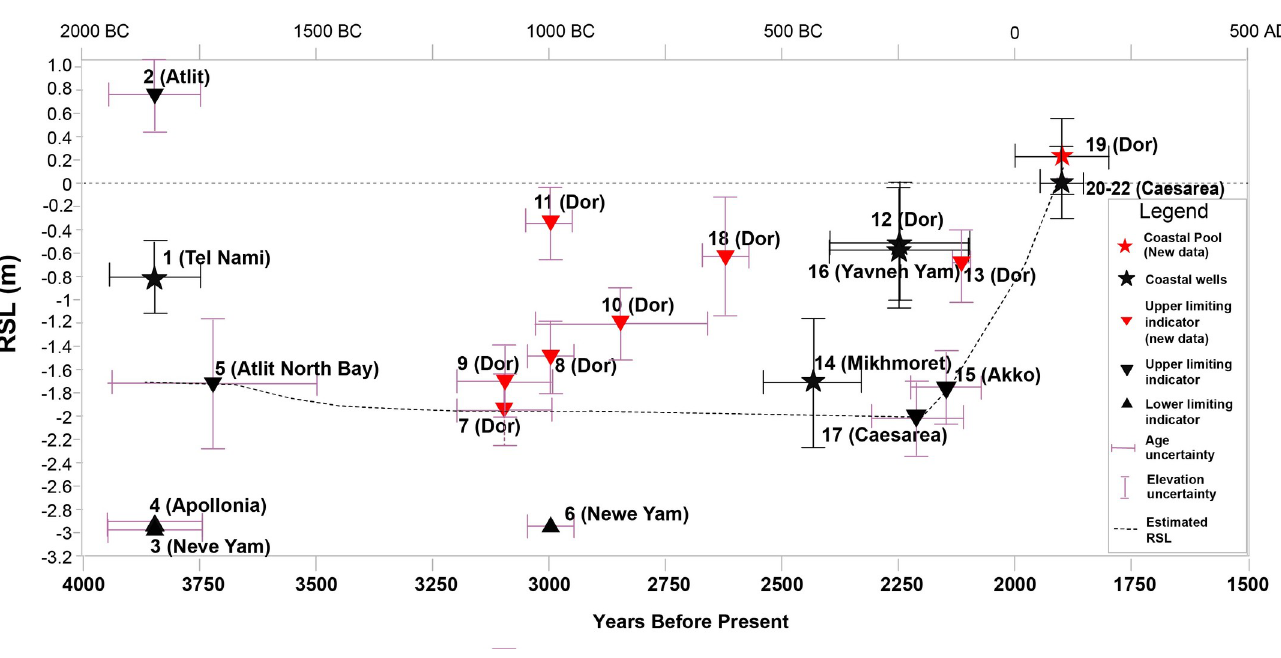
PLOS ONE | https://doi.org/10.1371/journal.pone.0251870 June 9, 2021 12 /